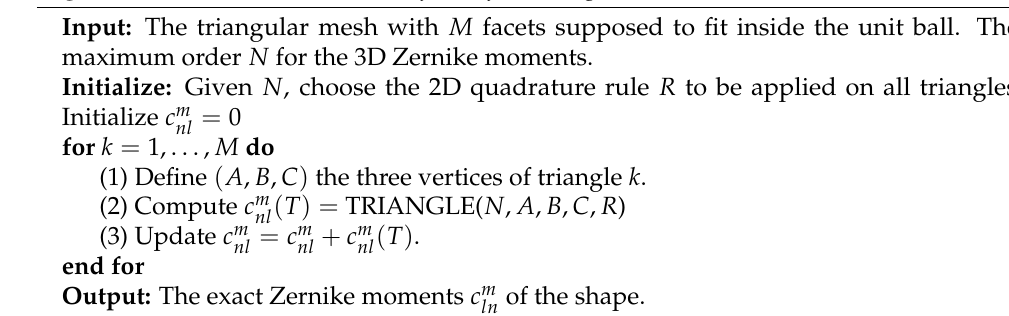
Algorithm 2 Exact Zernike moments for surface triangular